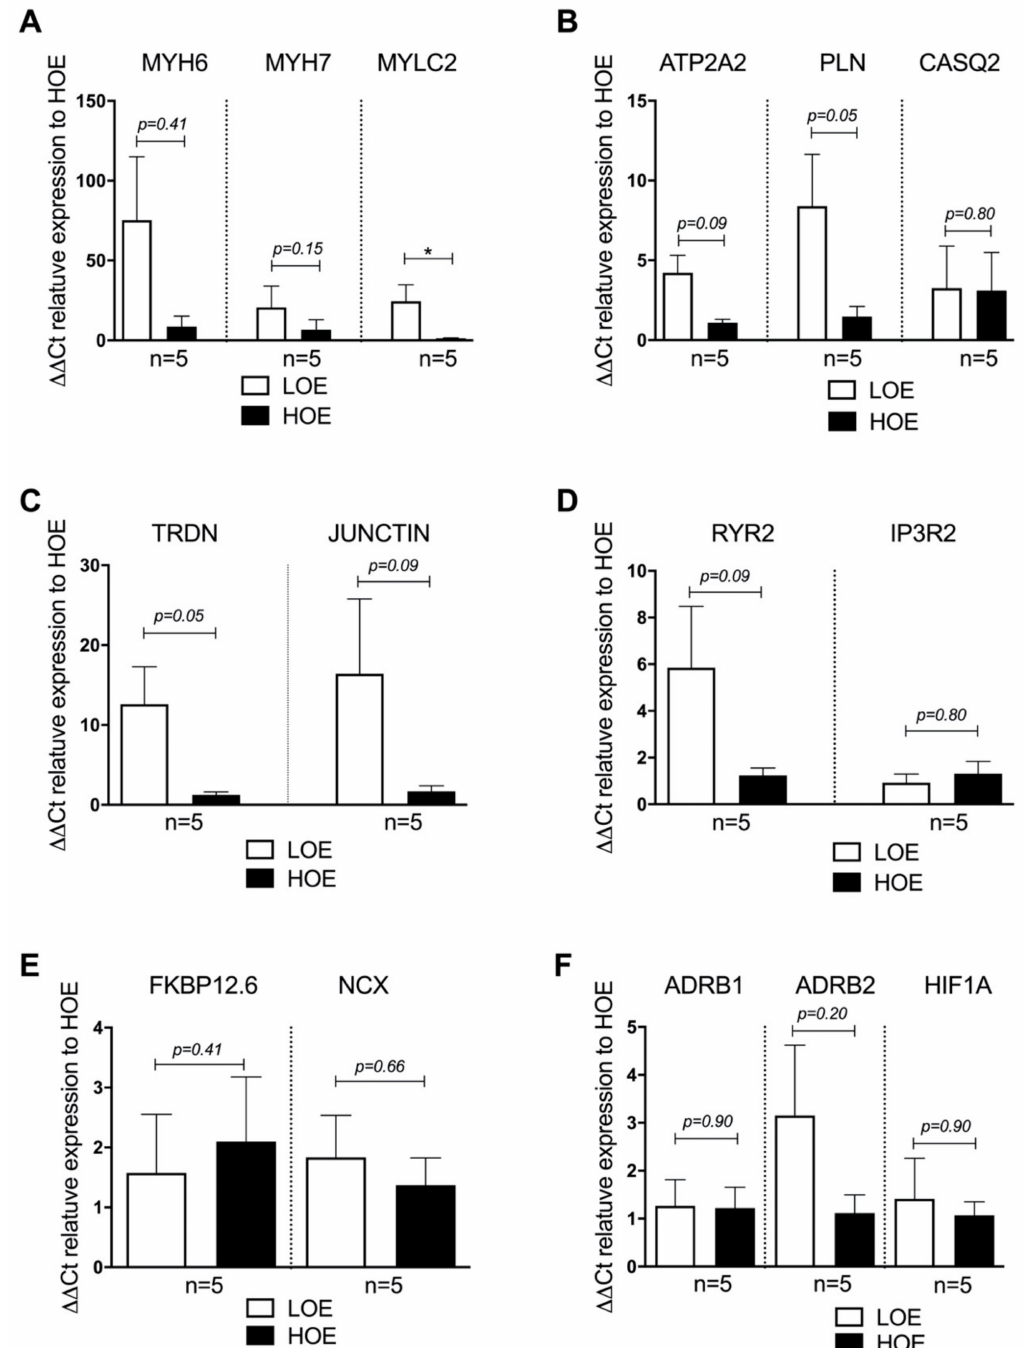
Figure 5. 3D cardiac spheroids differentiated under LOE exhibit higher expression in key cardiac markers. Relative gene expression analysis by qRT-PCR in 25-day-old hPSC-CMs (using hiPSC UEFhfiPS1.4 and hESC CCTL12 lines) obtained from 3D cardiac spheroids differentiated in LOE (white bars) and HOE (black bars) conditions. ( A ) MYH6 = alpha-myosin- heavy-chain ( n = 5); MYH7 = beta-myosin-heavy-chain ( n = 5); MYL2 = Myosin Light Chain 2 ( n = 5); ( B ) ATP2A2 = ATPase Sarcoplasmic/Endoplasmic Reticulum Ca 2+ Transporting 2 ( n = 5); PLN = phospholamban ( n = 5); CASQ2 = calsequestrin 2 ( n = 5); ( C ) RYR2 = ryanodine receptor type 2 ( n = 5); IP3R2 = inositol 1,4,5-triphosphate type 2 receptor ( n = 5); ( D ) FKBP12.6 = Calstabin 2 ( n = 5); NCX = Na + Ca 2+ exchanger ( n = 5); ( E ) TRDN = triadin ( n = 5); JUNCTIN = Junctin ( n = 5); ( F ) ADRB1 = beta-1 adrenergic receptor (adrenoceptor beta 1) ( n = 5); ADRB2 = beta-2 adrenergic receptor (adrenoceptor beta 2) ( n = 5); HIF1A (hypoxia-inducible factor 1-alpha ( n = 5). Glyceraldehyde-3-phosphate dehydrogenase (GAPDH) was used as housekeeping gene. The number of experiments is 5 independent biological replicates for each bar graph. Data are shown as mean ± SEM. Significance was calculated by Mann-Whitney test. *, p <